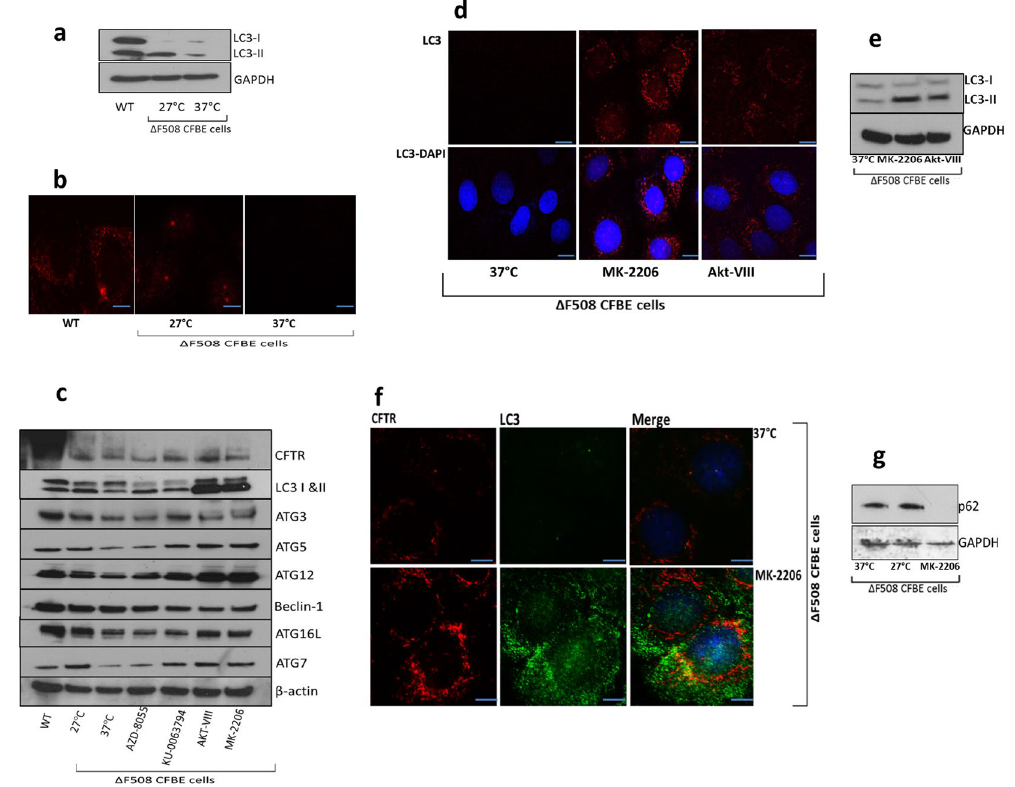
Figure 4. Autophagy is restored in Δ F508 CFBE41o- cells upon treatment with MK-2206 and AKT-VIII. ( a ) Protein expression of LC3-I, LC3-II was determined by immunoblotting in WT HBE41o- cells, Δ F508 CFBE41o- cells (37 °C) and Δ F508 CFBE41o- cells temperature shifted to 27 °C. ( b ) Subcellular localization of LC3 (red- 549 nm) was detected in WT HBE41o- cells, Δ F508 CFBE41o- cells (37 °C) and CFBE41o- cells temperature shifted to 27 °C. ( c) Δ F508 CFBE41o- cells (37 °C) were treated with AZD-8055, KU-0063794, AKT-VIII and MK-2206 and protein expression of autophagy markers was determined by immunoblotting (LC3-I and -II, ATG3, ATG5, ATG7, ATG12, ATG16l and beclin-1) in addition to CFTR and β -actin. WT HBE41o- cells and Δ F508 CFBE41o- cells at 27 °C were included as positive controls and Δ F508 CFBE41o- cells at 37 °C were included as negative controls. ( d ) Fluorescent detection was used to visualise LC3 (red- 549 nm) in Δ F508 CFBE41o- (37 °C) treated with MK-2206 and AKT-VIII ( e ) Δ F508 CFBE41o- cells (37 °C) were treated with AKT-VIII and MK-2206 along with negative control Δ F508 CFBE41o- cells at 37 °C and protein expression of LC3-I, LC3-II and GAPDH was determined by immunoblotting. ( f ) Co-localisation of CFTR (red- 549 nm) and LC3 (green- 488 nm) in Δ F508 CFBE41o- cells treated with MK-2206 and a negative control CFBE41o- cells at 37 °C. Nuclei were stained with DAPI (blue- 358 nm). Scale bar is 10 µ m. ( g) Protein expression of p62 was determined in Δ F508 CFBE41o- cells (37 °C), Δ F508 CFB41o-E cells (27 °C) and Δ F508 CFBE41o- cells treated with